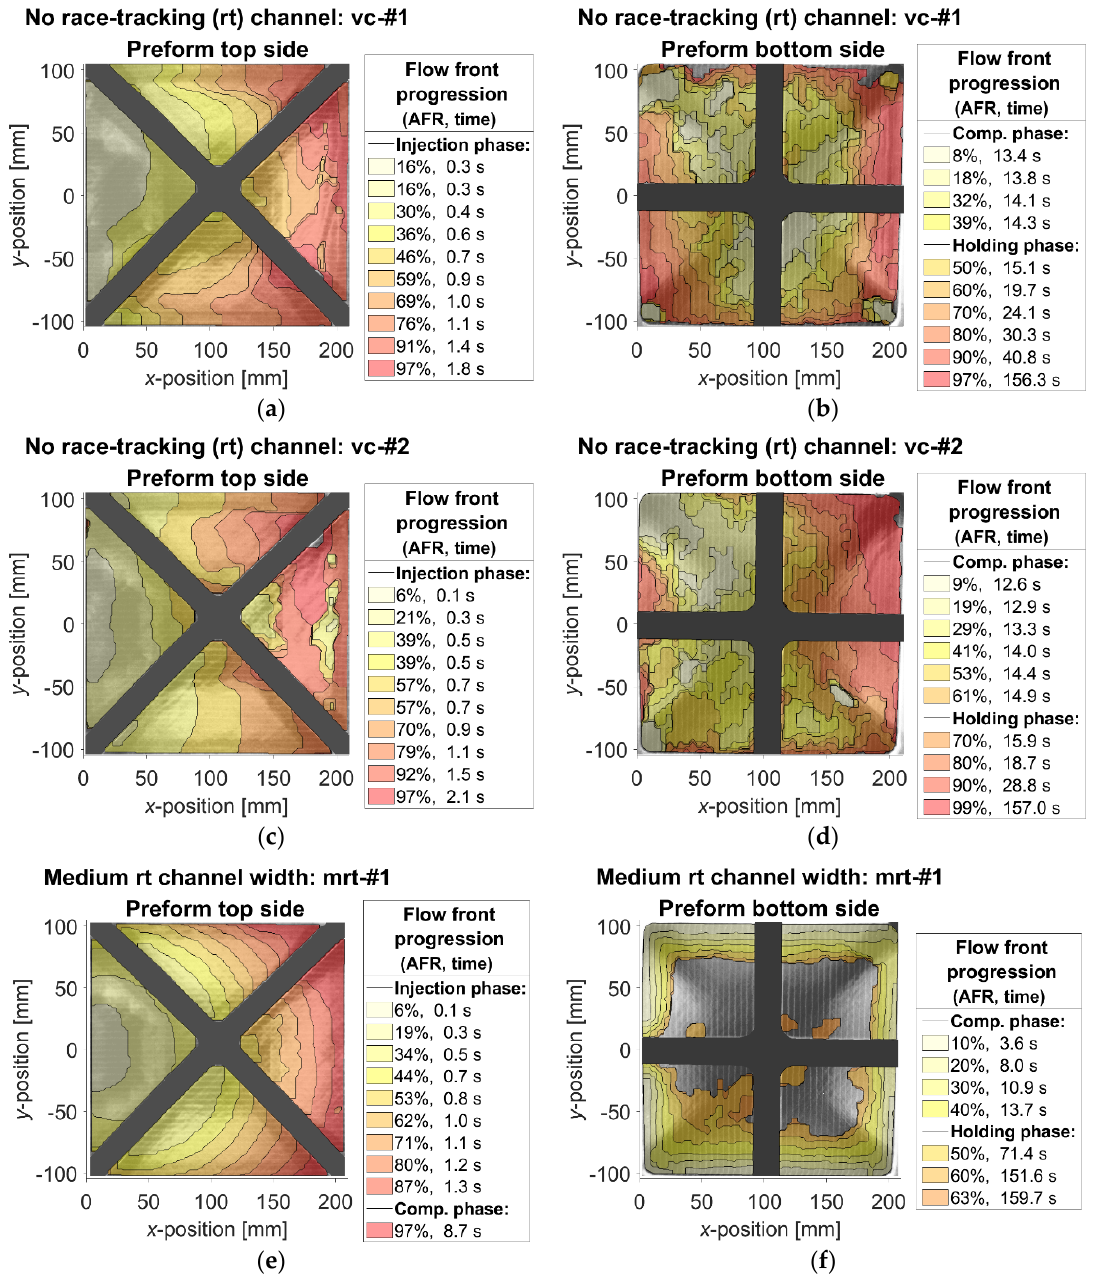
Figure A5. Flow front progression of FS-CRTM experiments of the race-tracking study: ( a , b ) no race-tracking (rt) channel—vc-#1; ( c , d ) no race-tracking channel—vc-#2; ( e , f ) medium race-tracking channel width—mrt-#1 (AFR = area filling ratio).